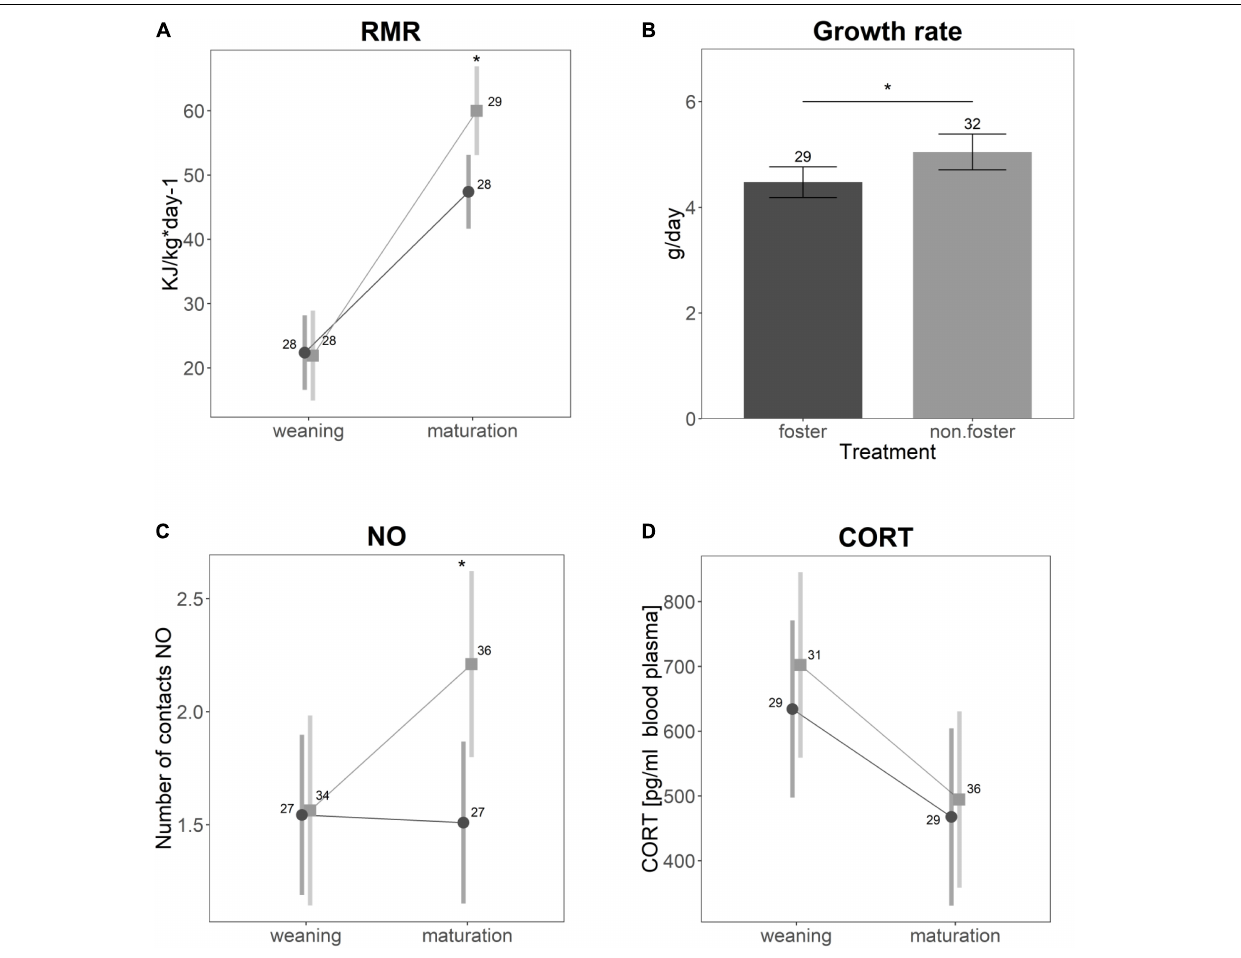
(same: + 0.77 ± 0.75 g; down: + 1.84 ± 0.87 g; up: 1.04 ± 0.89